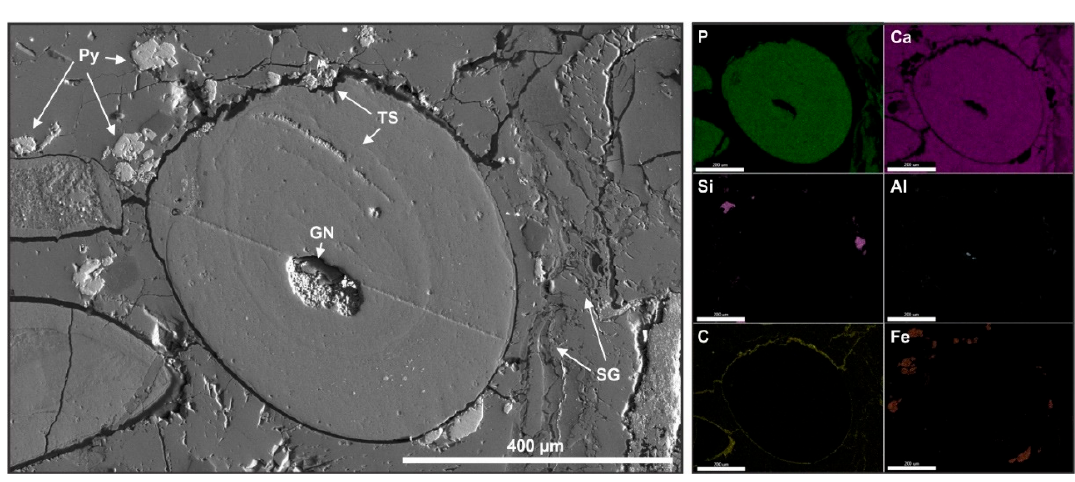
Figure 8. Detailed SEM image of sample CD13 centered on apatite coated grain, acquired with ET detector BSE mode, and SDD-EDS elemental maps of select major and trace elements. The grain in the center has an aluminosilicate nucleus (GN), and is compositionally homogeneous, but contains a subtle internal truncation surface (TS), as well as an external one. Apatite fragments on the right are partially phosphatized skeletal fragments (SG). Relatively large euhedral pyrite crystals (Py) are present near the edges of the coated grain. Cement is predominantly calcite, and solid bitumen is concentrated around grain contacts.